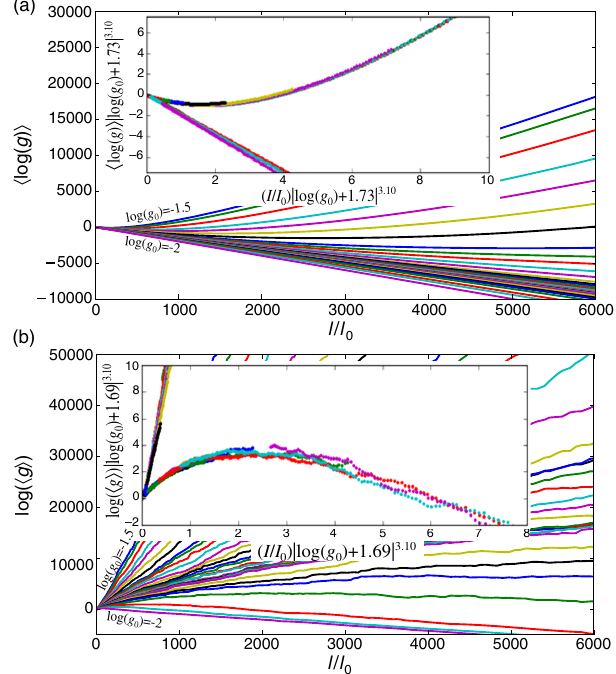
FIG. 2. The many-body localization transition tuned by the bare coupling g 0 as seen in the RG flow of the dimensionless coupling g ¼ Γ = Δ . In the thermal phase, g grows exponentially with block length l (linearly with the dimension of the block ’ s Hilbert space), whereas in the localized phase, g decreases exponentially. (a) Plot of the “ typical ” variable h log g i versus l . The data in the thermal side show good scaling collapse with the critical exponent ν ≈ 3 . 1 (inset). On the insulating side, on the other hand, h log g i decreases linearly with a nonuniversal slope that depends weakly on the value of log g 0 . (b) Plot of the “ average ” variable log h g i versus l . This variable does collapse to a nontrivial scaling function on the insulating side of the transition with the same critical exponent obtained above on the metallic side. The fact that the critical fluctuations affect only the average quantity log h g i suggests that they consist of exponentially rare, long thermal clusters inside the insulator. These fluctuations do not contribute to h log g i